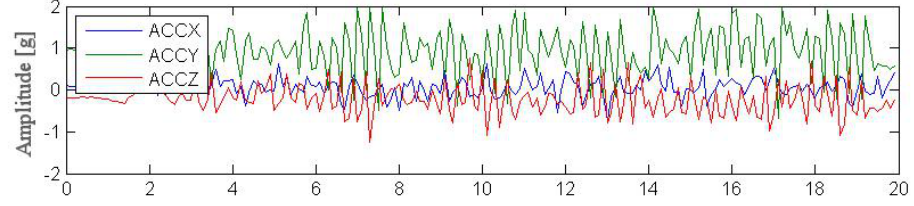
Figure 9. Data acquired from wearable accelerometer during a 20 s run.